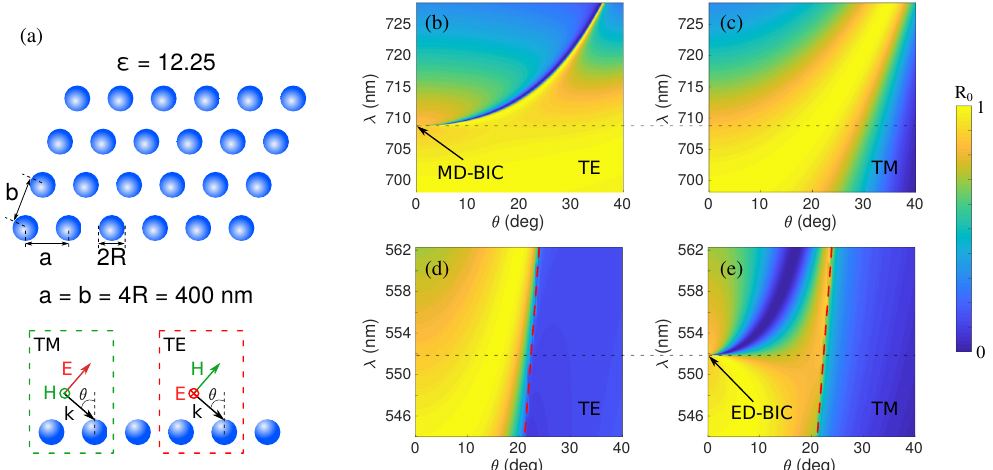
Figure 1. Color maps of the reflectance as a function of wavelength and angle of incidence for both polarizations for a square array of dielectric spheres (radius R = 100 nm) of constant dielectric permittivity (cid:101) = 12.25 ( n = 3.5, similar to that of Si in the visible), with lattice constants a = b = 4 R = 400 nm, as shown in ( a ), in the vicinity of two different bound states in the continuum (BICs) (at wavelengths indicated by black dashed horizontal lines): ( b , d ) TE and ( c , e ) TM polarizations. The symmetry-protected BICs emerge at: ( b ) MD-BIC for TE polarization at λ = 709 nm and ( e ) ED- BIC for TM polarization at λ = 552 nm. Dashed red lines in ( d , e ) delimit the diffractive regions (right); none in ( b , c